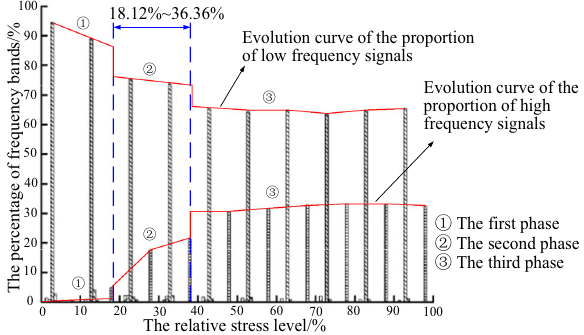
Fig. 12 Diagram of the low–high frequency conversion mode of acoustic emission signals before the peak stress of weakly cemented